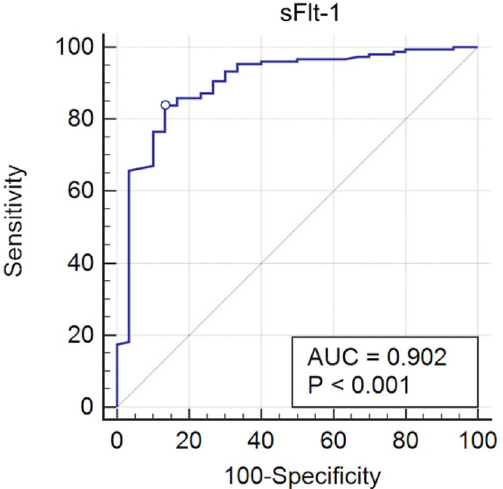
Figure 1. Receiver operating characteristic (ROC) analysis of sFlt-1 serum levels between SARS-CoV-2 infected and non-infected patients; the circle indicates the cut-off point (90.3 pg/mL) with 83.89% Sensitivity and 86.67% Specificity for positive patients. AUC denotes area under the curve.